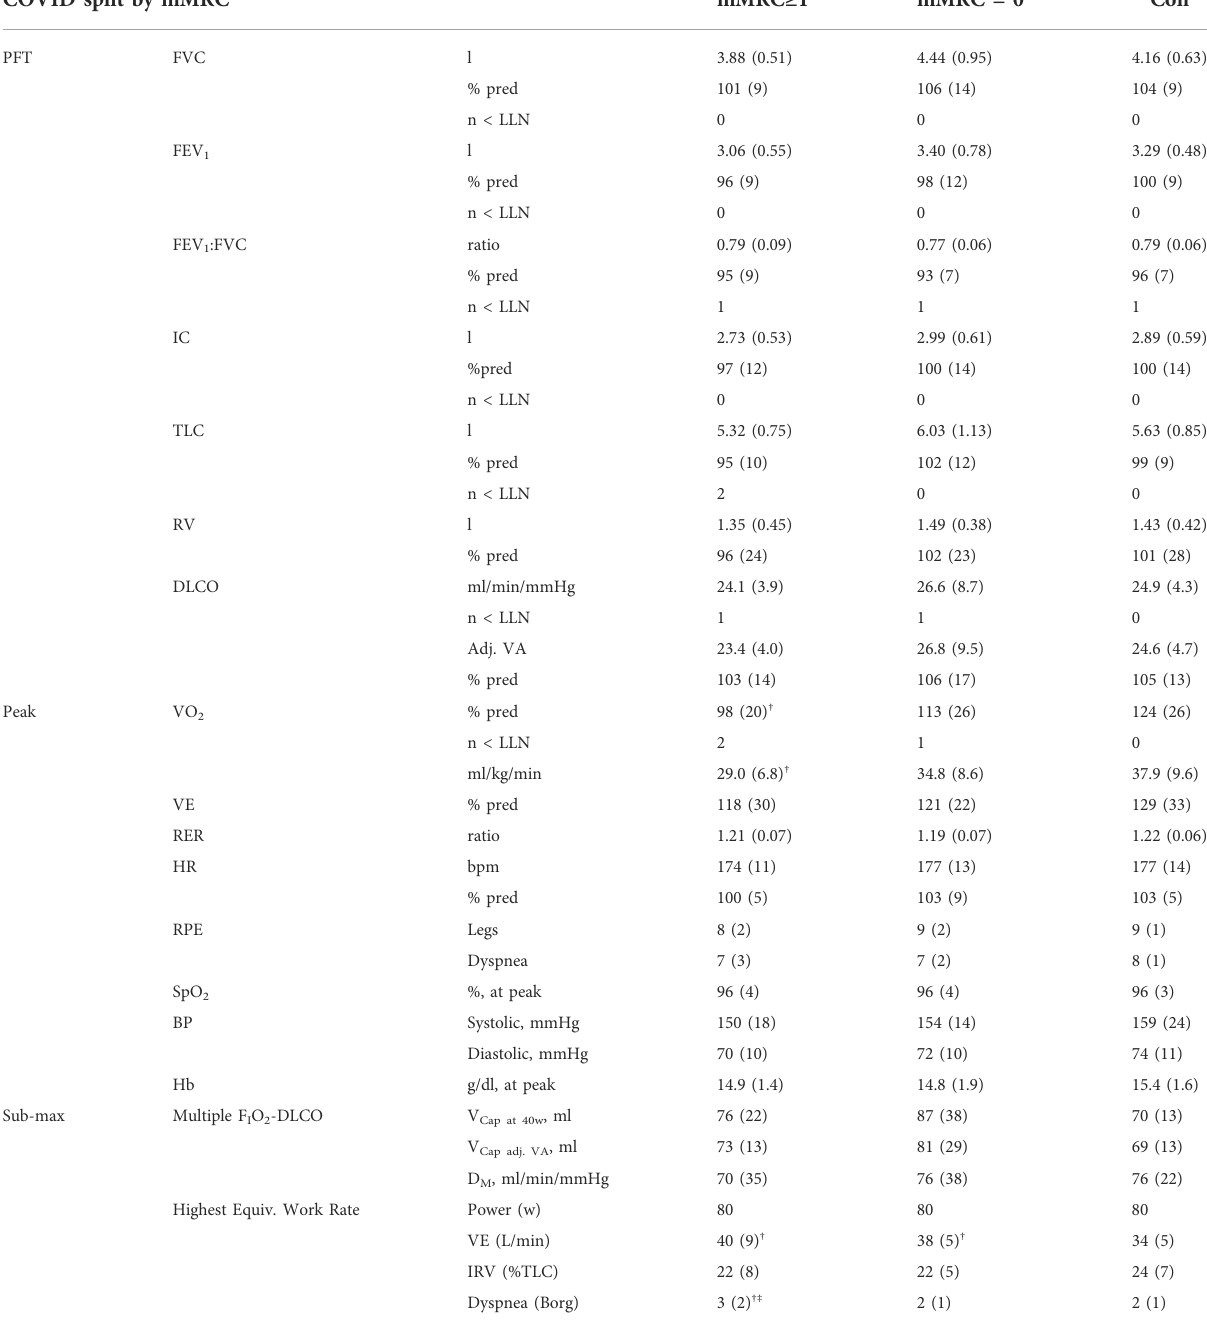
TABLE4Restingpulmonaryfunction(pulmonaryfunctiontest,PFT) andsubmaximalandpeakexercisedataformMRC ≥ 1(dyspneic-CoV),mMRC=0 and